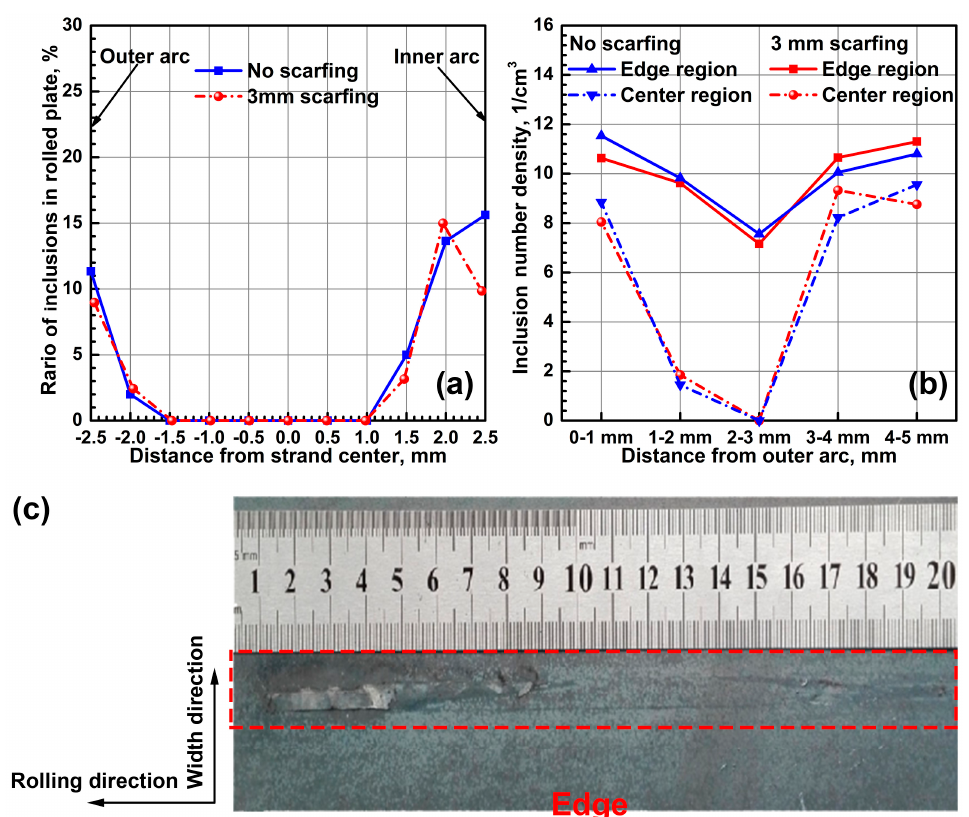
Figure 13. The distributions of inclusions along the thickness of the hot-rolled plate: the predicted results ( a ) and the measured results ( b ); the sliver defect of the hot-rolled plate ( c ).